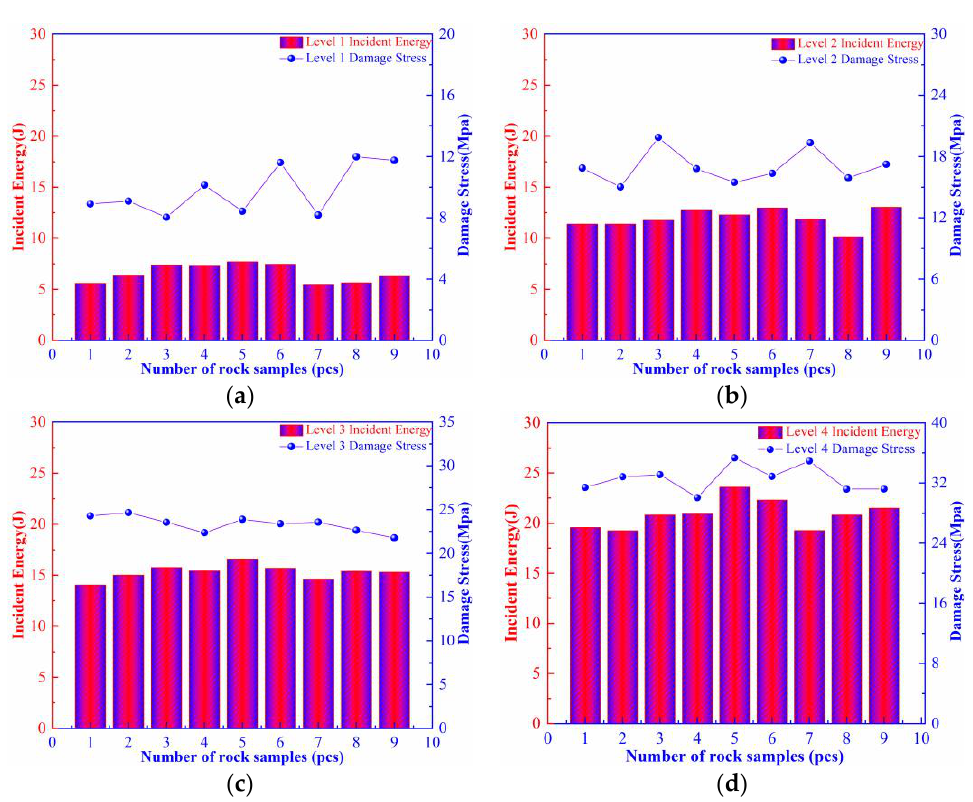
Figure 3. Peak stress and energy evolution statistics for rocks containing initial damage: ( a ) Level-I initial damage; ( b ) Level-II initial damage; ( c ) Level-III initial damage; ( d ) Level-IV initial